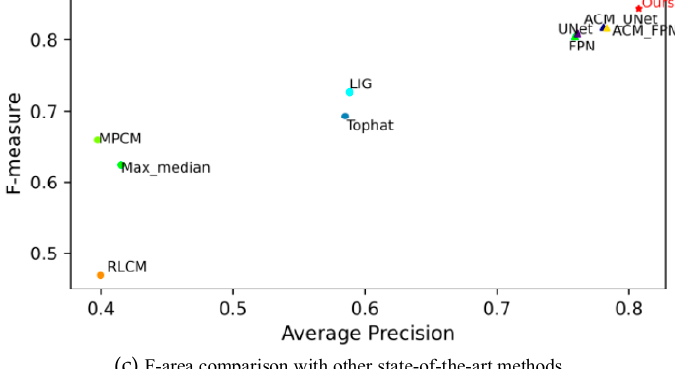
(b) Area under the ROC curve comparison with other state-of-the-art methods.